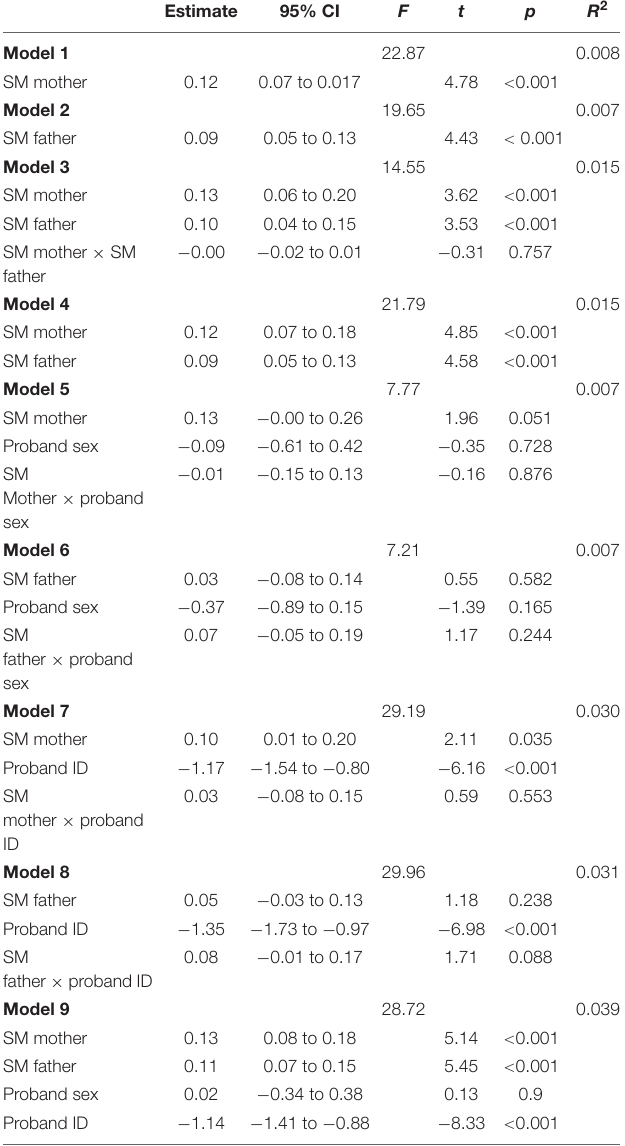
TABLE 2 | Summary of regression